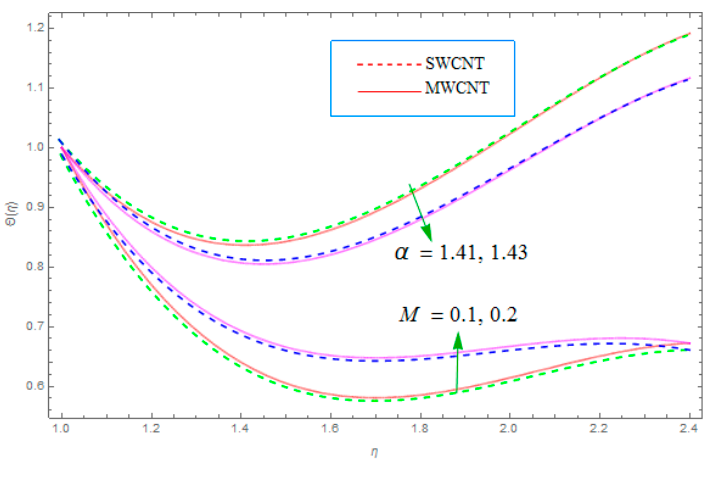
Figure 6. Distribution for varying M and α .